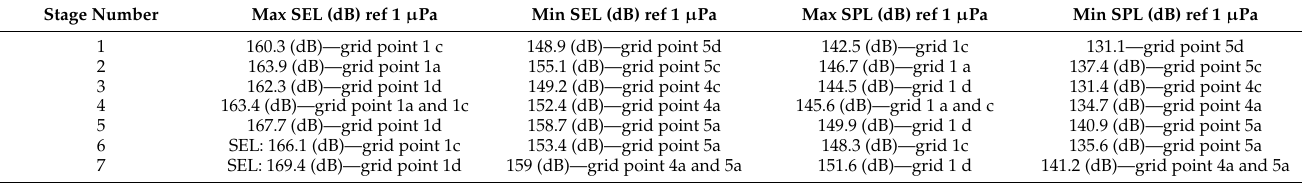
Table 1. Minima and maxima sound exposure level (SEL) and sound pressure level (SPL).